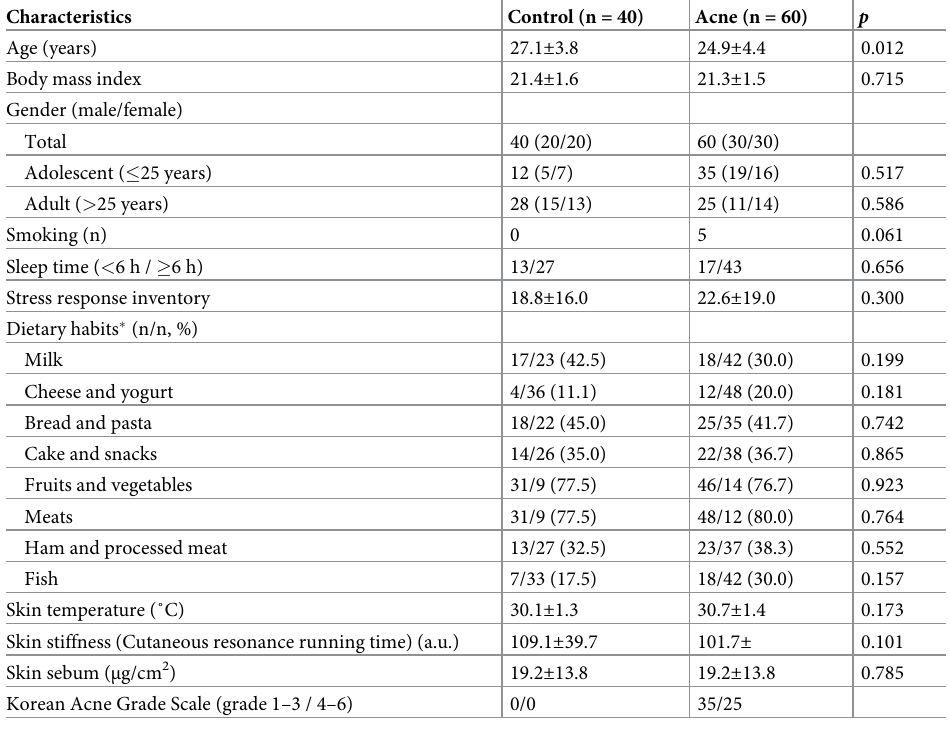
Table 3. Demographic characteristics of